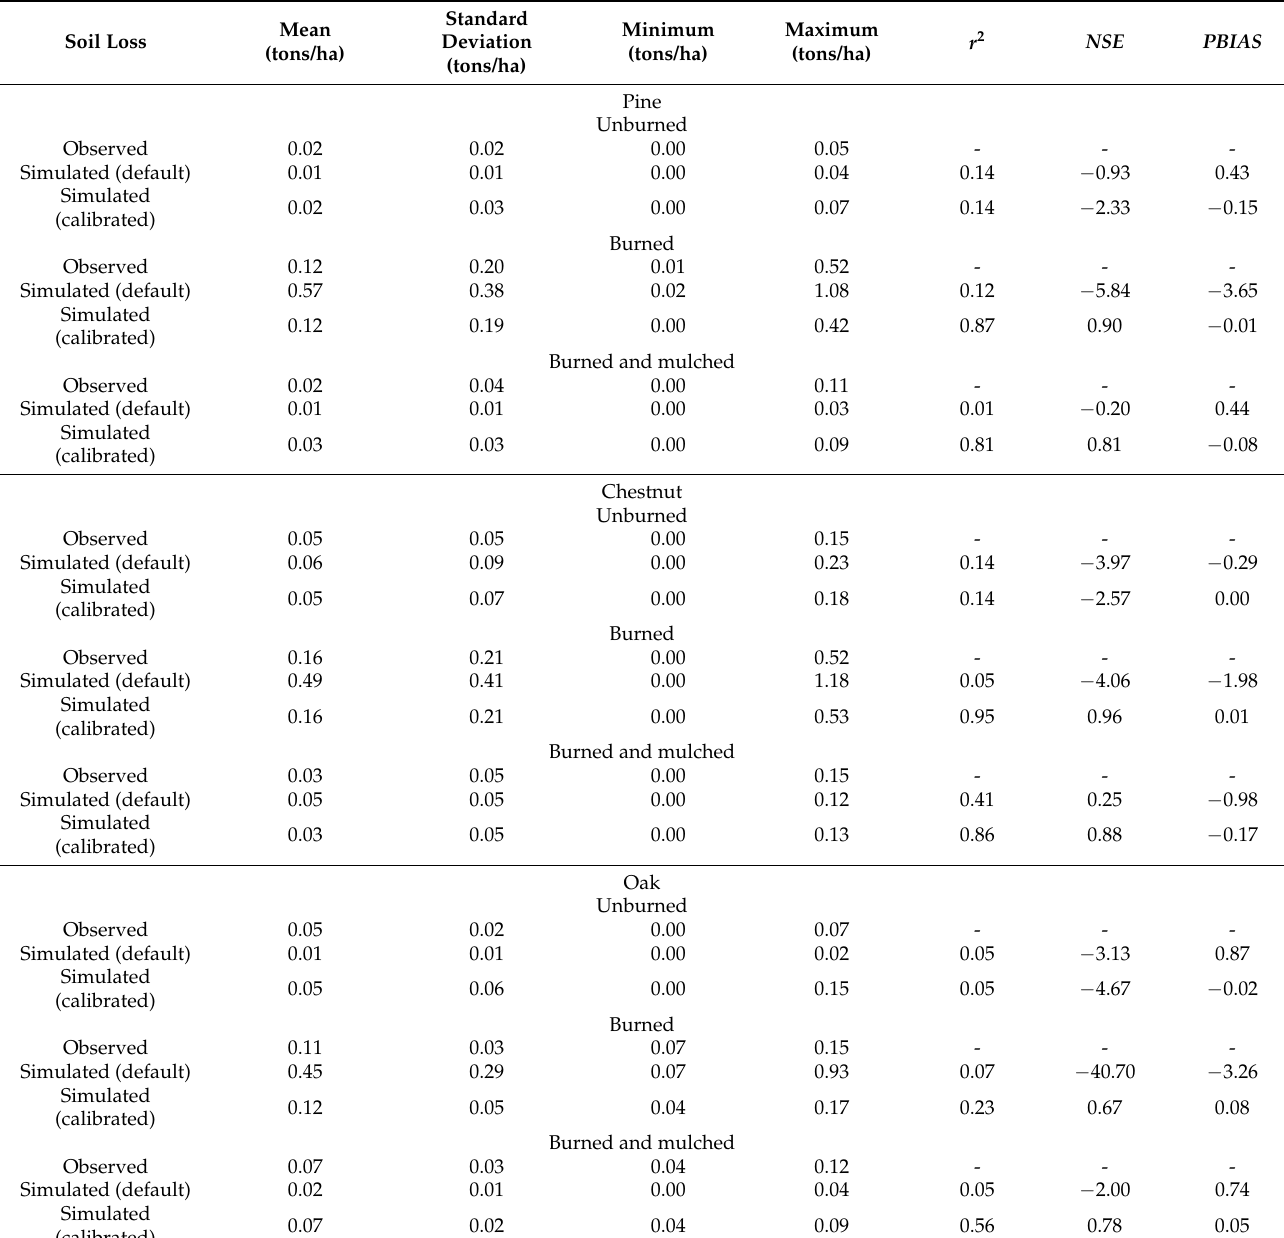
Table 6. Statistics and indexes to evaluate the runoff prediction capability of the USLE-M model in forest plots subject to prescribed fire and soil mulching with